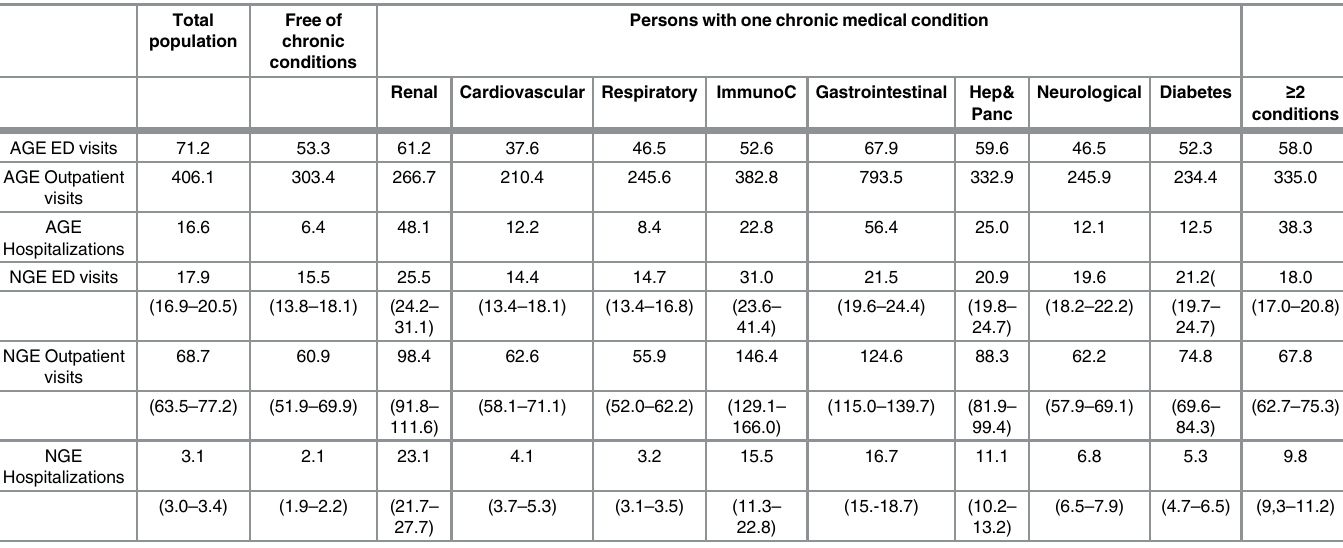
Table 4. Mean annual rate (per 10,000 person-years) of all-cause (AGE) and mean annual rate (per 10,000 person-years with 95% confidence inter- vals) of norovirus gastroenteritis (NGE) emergency department (ED), outpatient visits and hospitalizations in all age-groups: 2002 – 2013 Market- Scan database, age